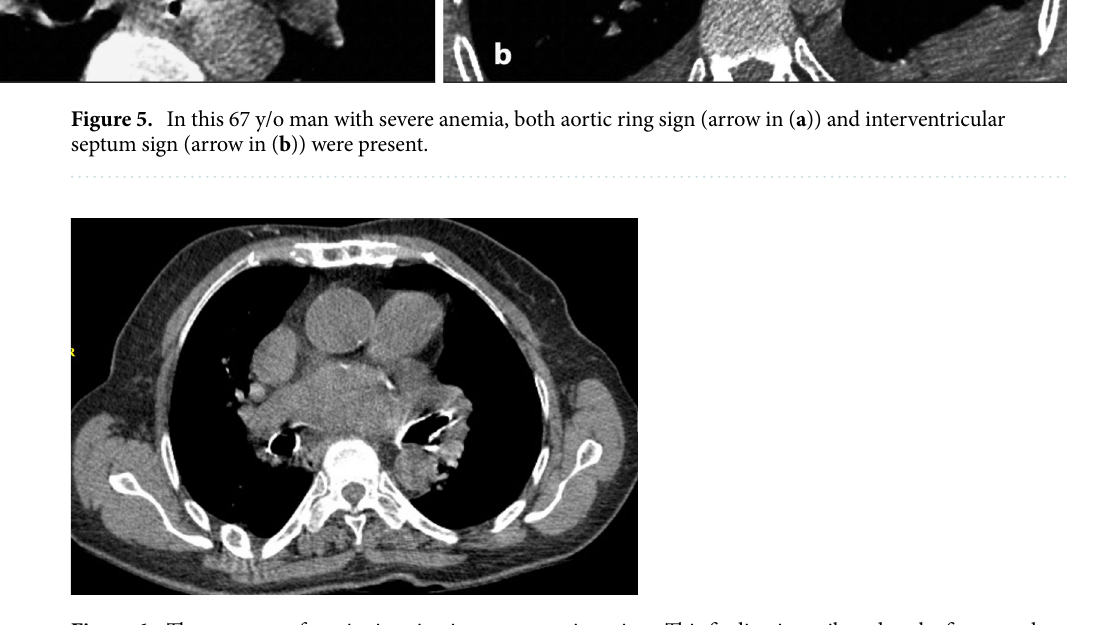
Figure 6. The presence of aortic ring sign in a nonanemic patient. This finding is attributed to the fine mural calcifications in the aortic